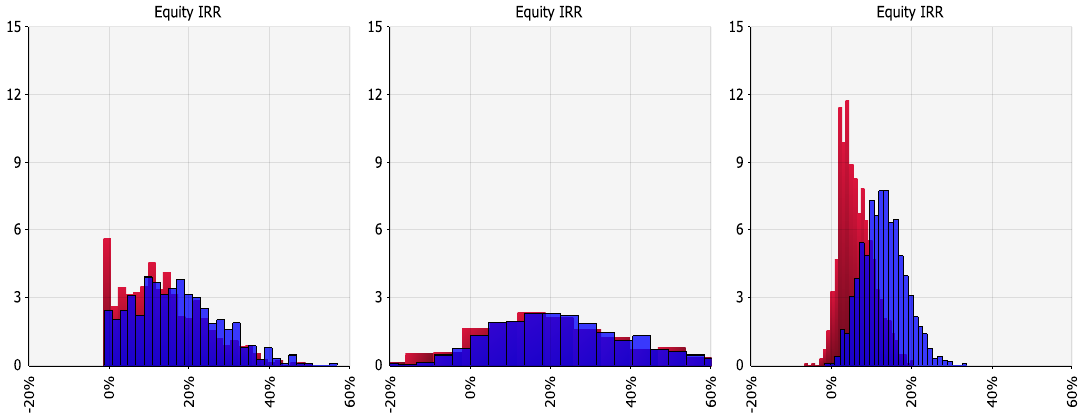
Figure 4. Equity IRR distributions of Coal, Wind, and Nuclear under 0% and 3% TGR.